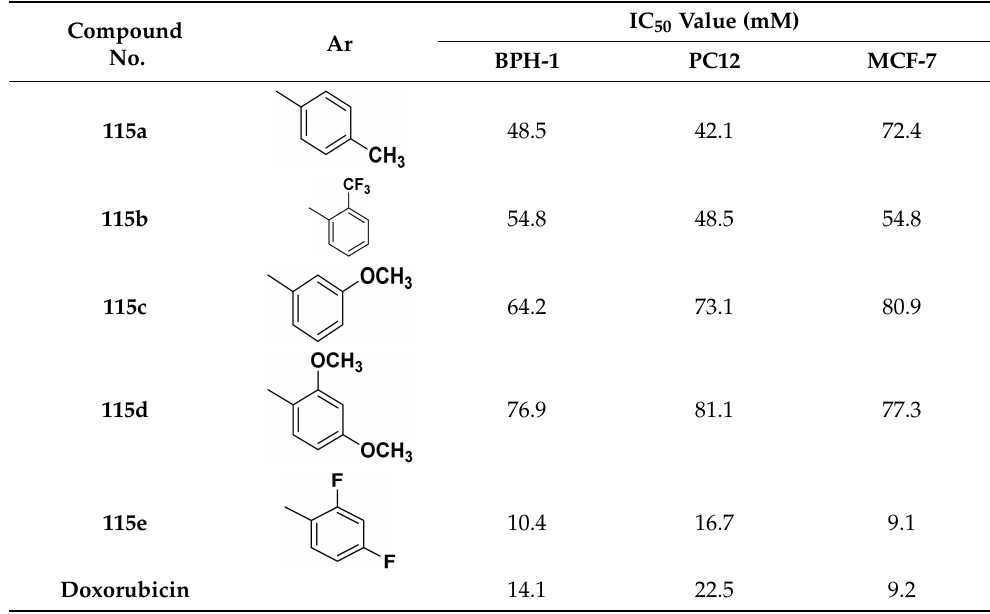
Figure 110. Structure of chalcone ‐ based quinoxalin hybrids and the most promising compound 115e.